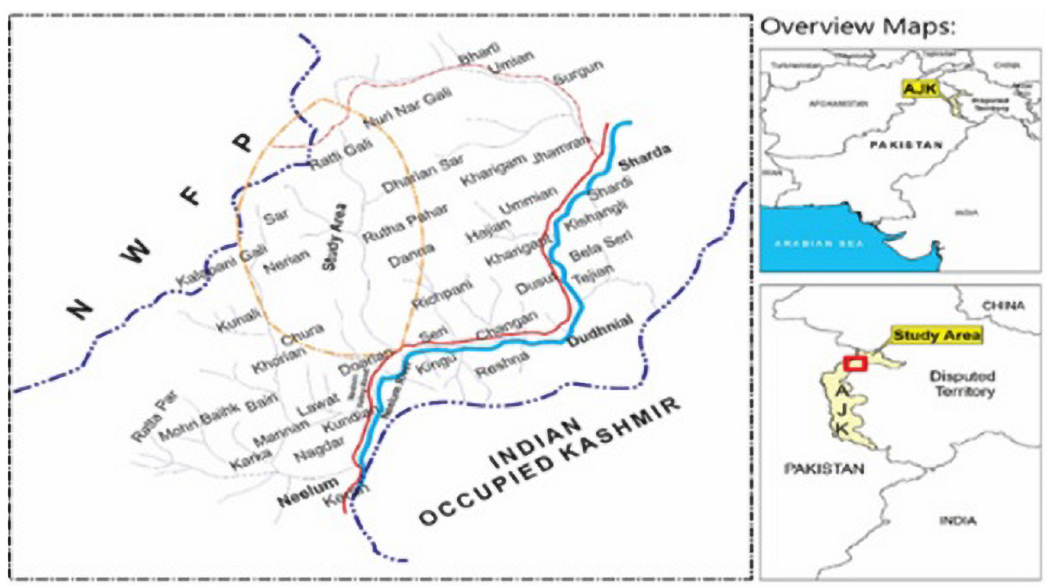
Fig 1. Map of Darian and Rati Gali, District Neelam of Azad Jammu and Kashmir, Pakistan (note: Study sites are encircled).